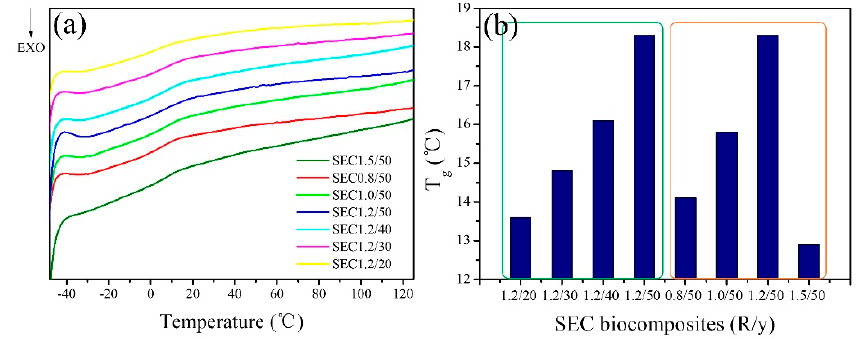
Figure 4. DSC curves ( a ) and T g values ( b ) of SEC biocomposites with different R values and ESOCA resin contents.